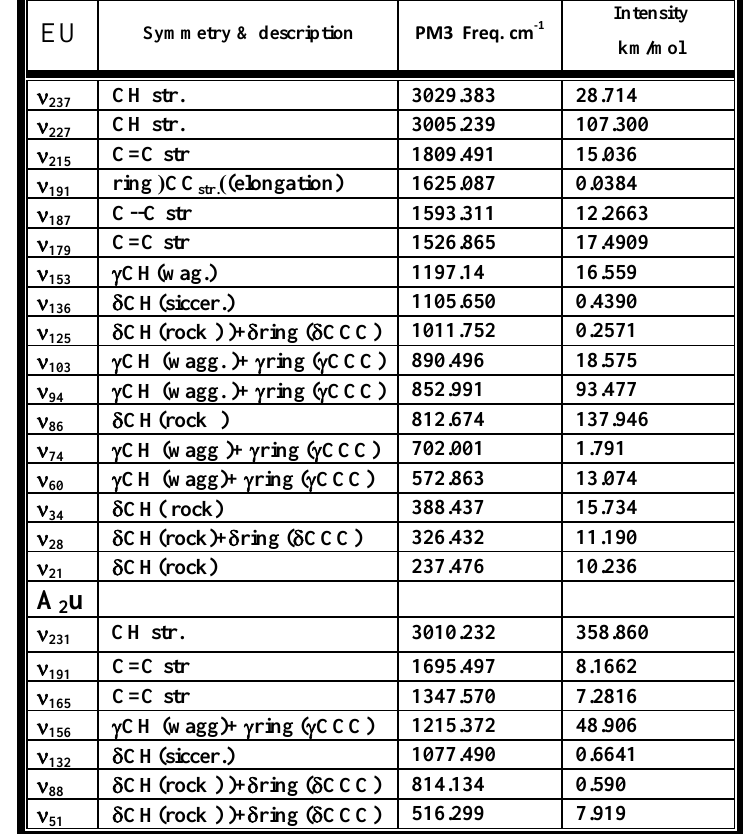
Table 3: Vibration frequencies and IR absorption intensities for (mono-rings layer (C as calculated applying G03